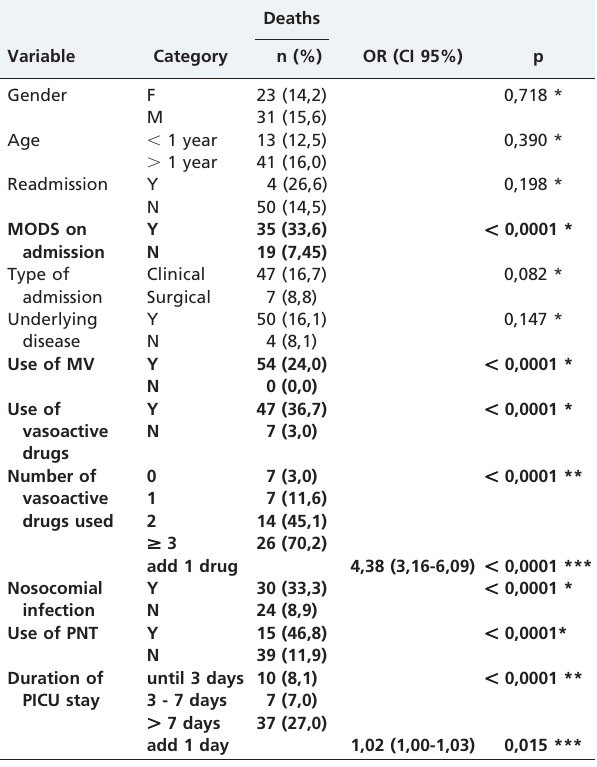
Table 1 - Characteristics of study population.